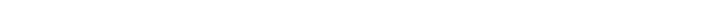
Table 1. Selected Avimer amino acid